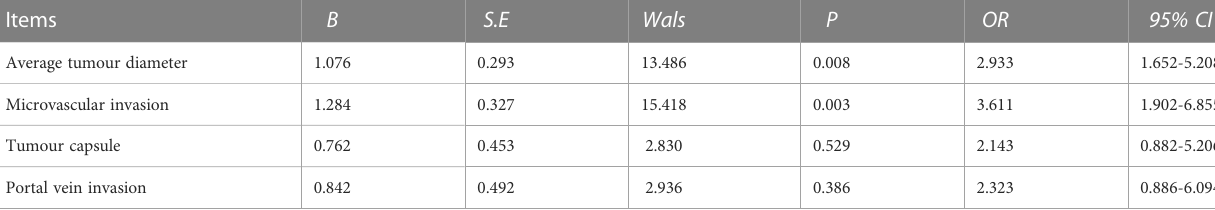
TABLE 5 Risk factors impacting postoperative